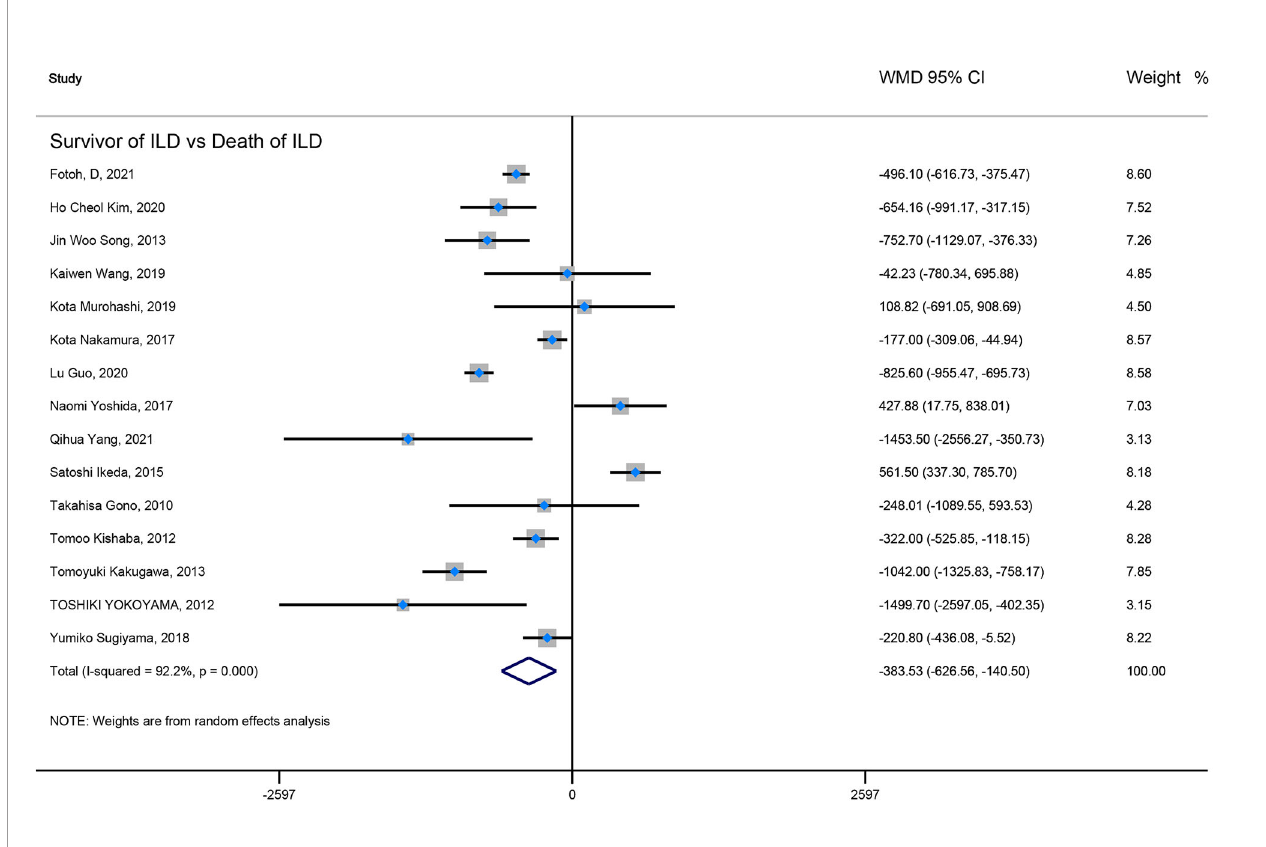
FIGURE 4 | The forest plot illustrated the WMD (95%CI) of KL-6 level between ILD survivor and death of